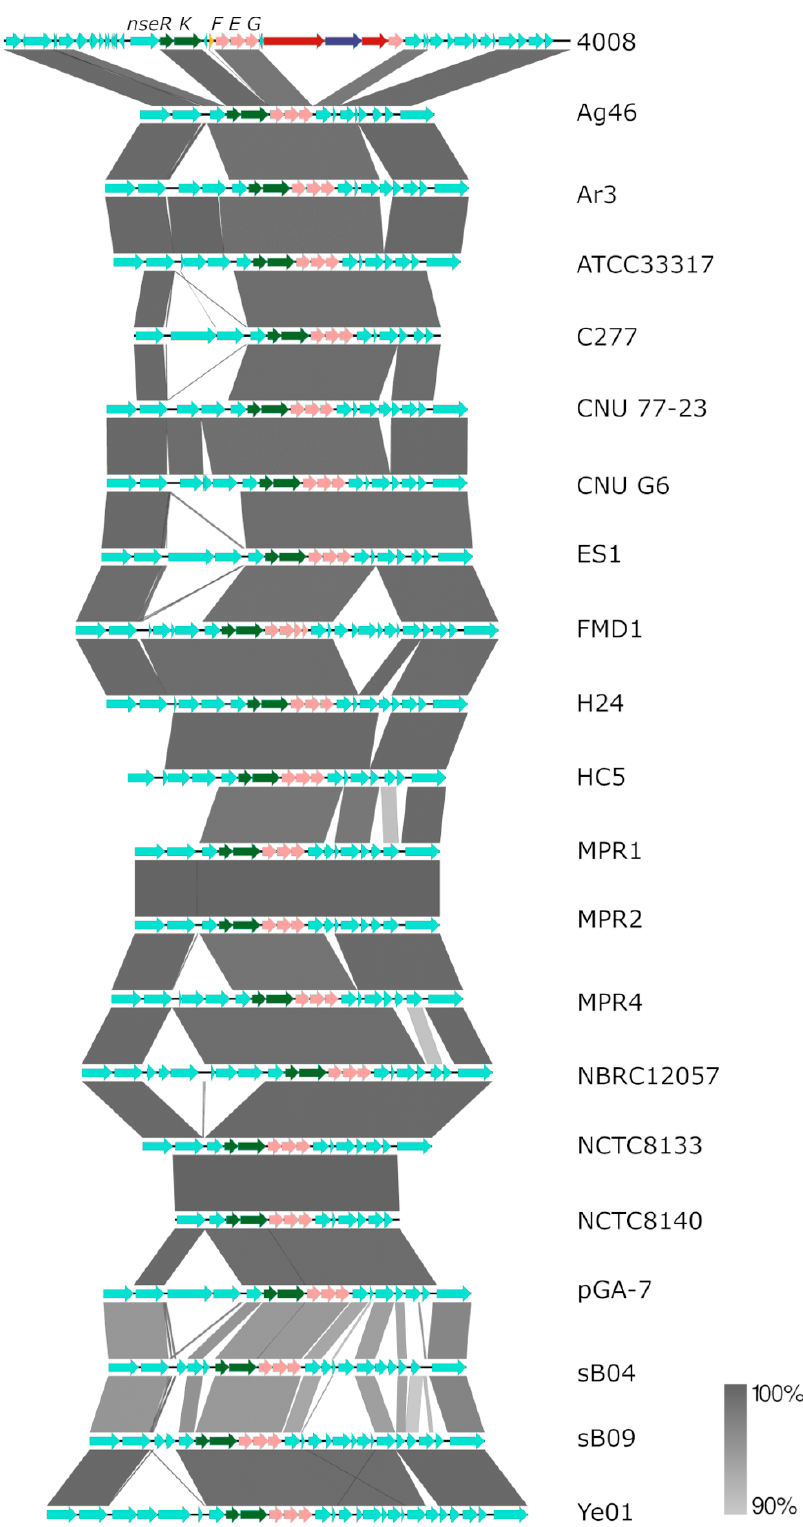
Figure 7. Multiple comparison of nisin E gene cluster and neighbouring open reading frames in Streptococcus equinus APC4008 with nseRKFEG , identified in publicly available S. equinus genomes. Scale represents nucleotide identity.